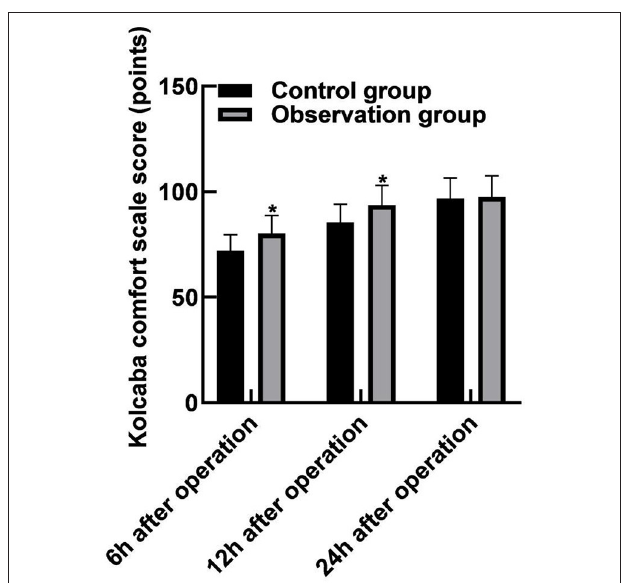
FIGURE 3 | Comparison of the comfort level during hospitalization between the two groups. Compared with the control group, * p < 0.05.